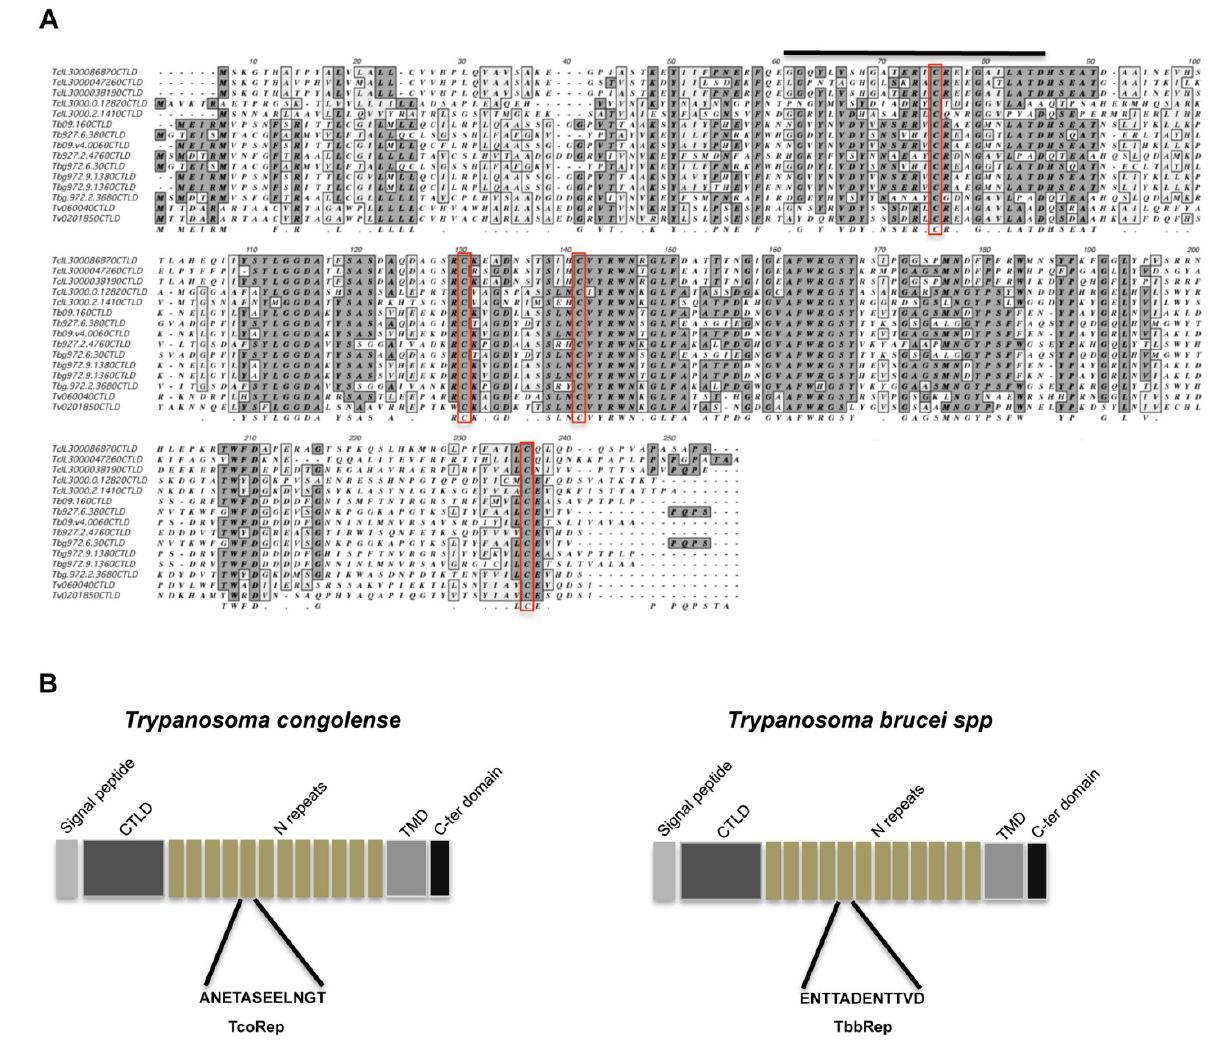
FIGURE 1: Comparison of Clec proteins in African trypanosomes. (A) Alignment of C-type lectin-like domain (CTLD) from African trypano- somes Clec proteins. Sequences were extracted and aligned using MacVector V11. Putative critical cysteines important for protein folding are indicated (red boxes) as well as link module (black line). Dark grey boxes contain identical residues, light grey boxes contain conserva- tive changes. TcIL3000, Trypanosoma congolense IL3000 (reference strain); Tb, Trypanosoma brucei brucei ; Tbg, Trypanosoma brucei gam- biense ; Tv, Trypanosoma vivax . (B) General features shared by Clec proteins in T. congolense and T. b. brucei . TMD, transmembrane do-